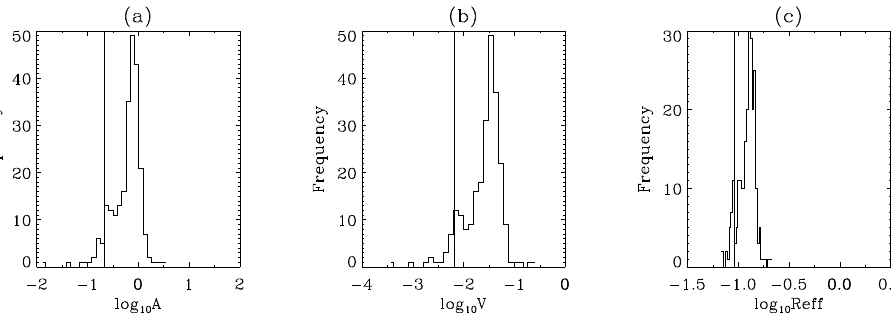
Fig. 6. As Fig. 5 but for the resulting integrated aerosol properties, surface area density (a) , volume density (b) and effective radius (c) . The vertical line indicates the a priori mean state (solid).